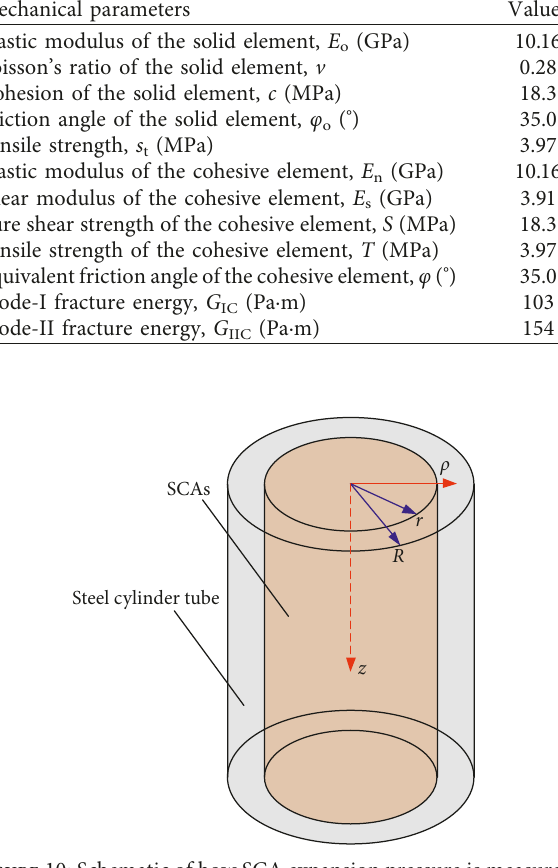
Figure 10: Schematic of how SCA expansion pressure is measured in a thick-walled steel cylinder